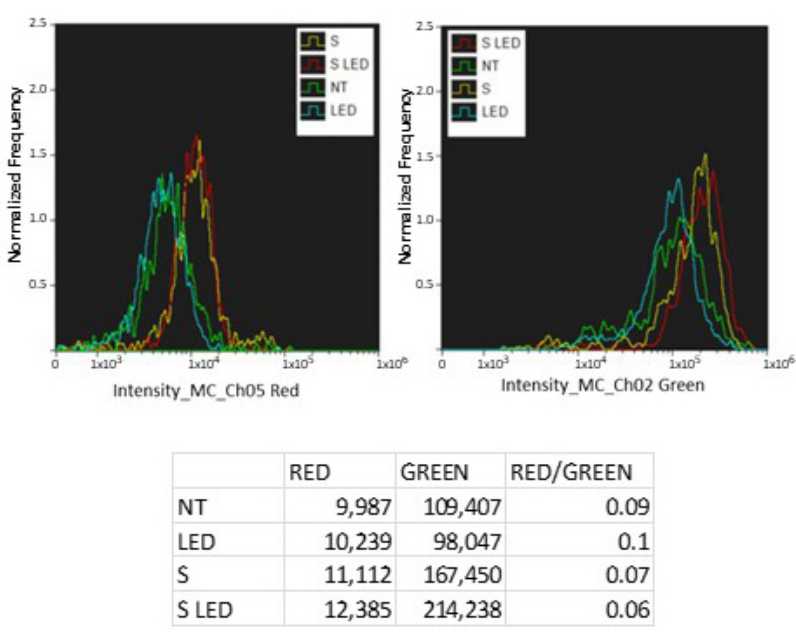
Figure 15. Cytofluorimetric analysis of JC-1 in T98G cells following NP BBR S administration and led stimulation. Cells (5 × 10 5 ) were placed onto 6-well plates and after 24 h of growing (reaching about a 70–80% confluence) were incubated for an additional 24 h with 10 8 of NP BBR S. ( A ) After trypsinization, JC-1 fluorescence was measured using 488 and 642 nm laser excitation in untreated (NT), LED-only treated (4 min at 447 nm and 1.2 mW/cm 2 of intensity), NP BBR S administration (S), and combined with LED stimulation (S LED). ( B ) Fluorescence intensity (in arbitrary units) measured at Ch05 (Red) and Ch02 (Green) channels are reported with red/green ratio.